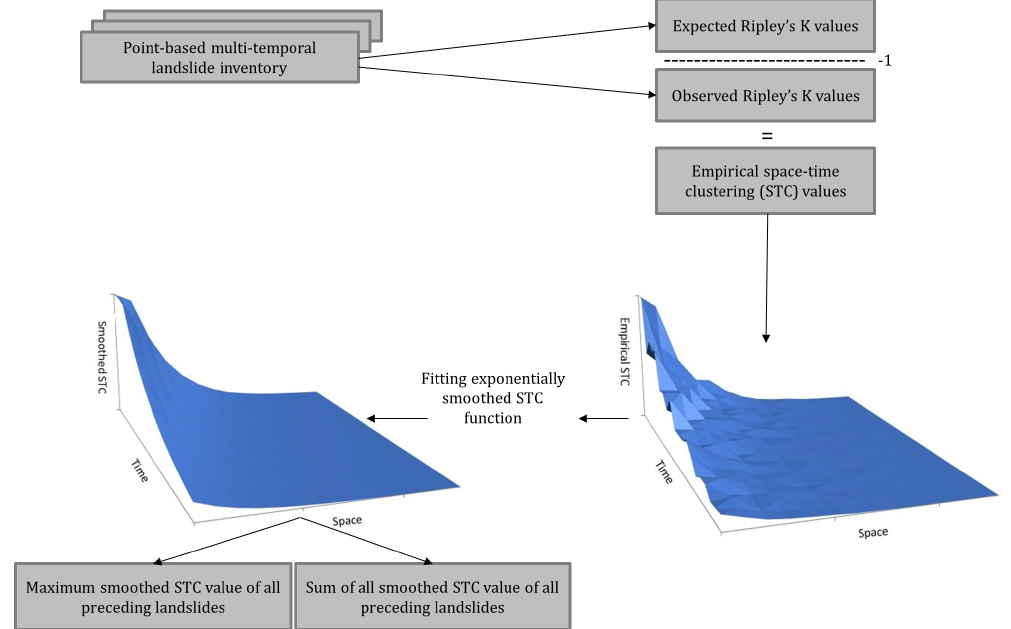
Figure 5. Procedure to compute the two landslide path-dependency variables using Ripley’s space–time K